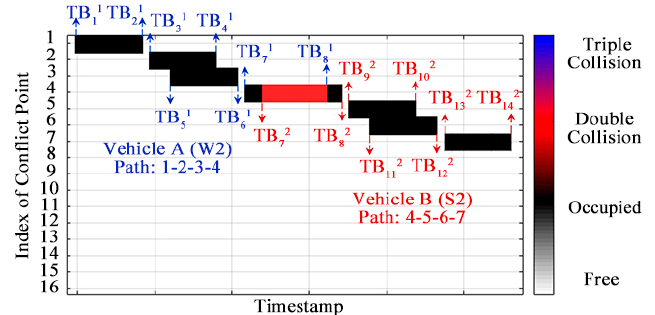
Figure 10. The location of the time blocks of vehicle A and B.